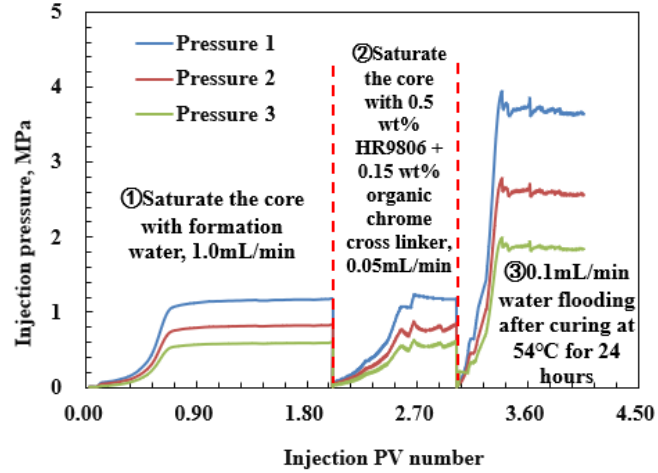
Figure 9. Pressure curve of 0.50 wt % HR9806 + 0.15 wt % crosslinker plugging experiment.